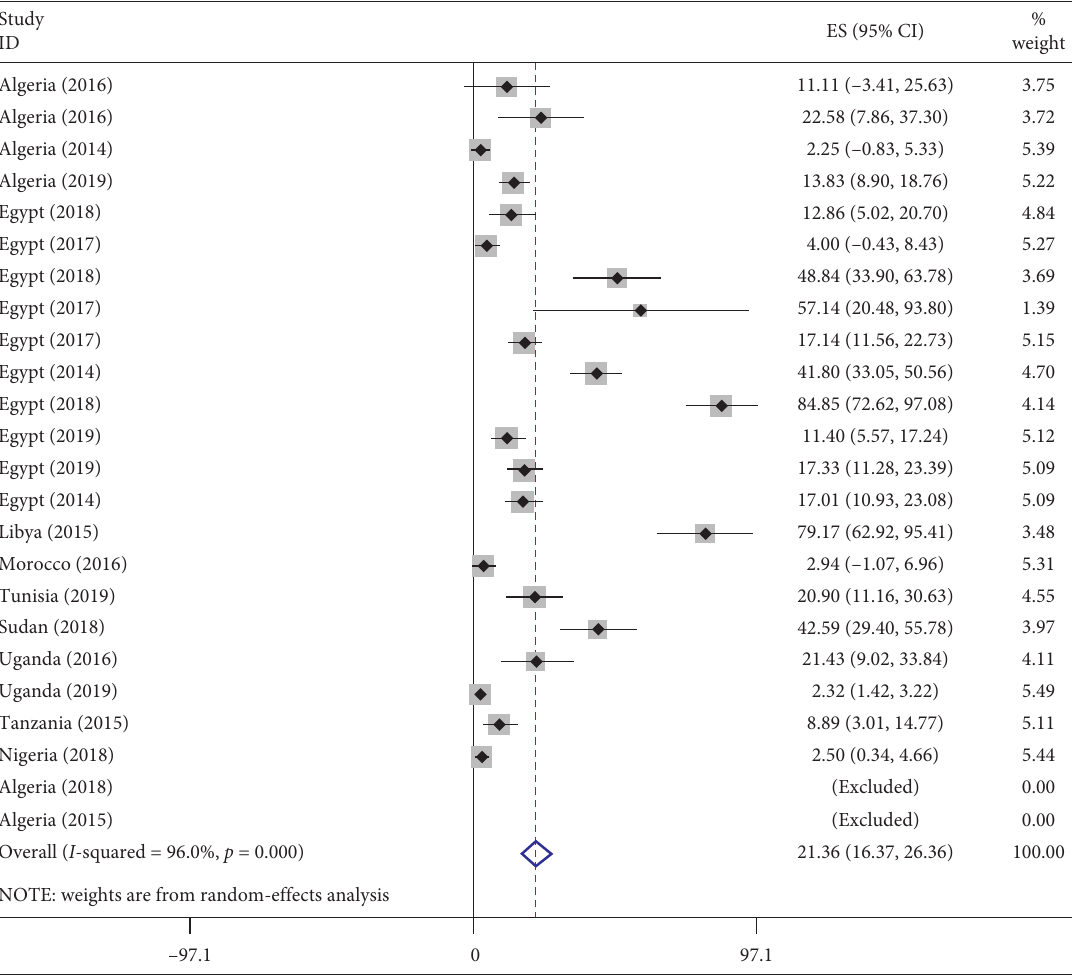
Figure 3: Forest plot for the pooled prevalence of CPPA isolates in Africa from 2007 to 2018